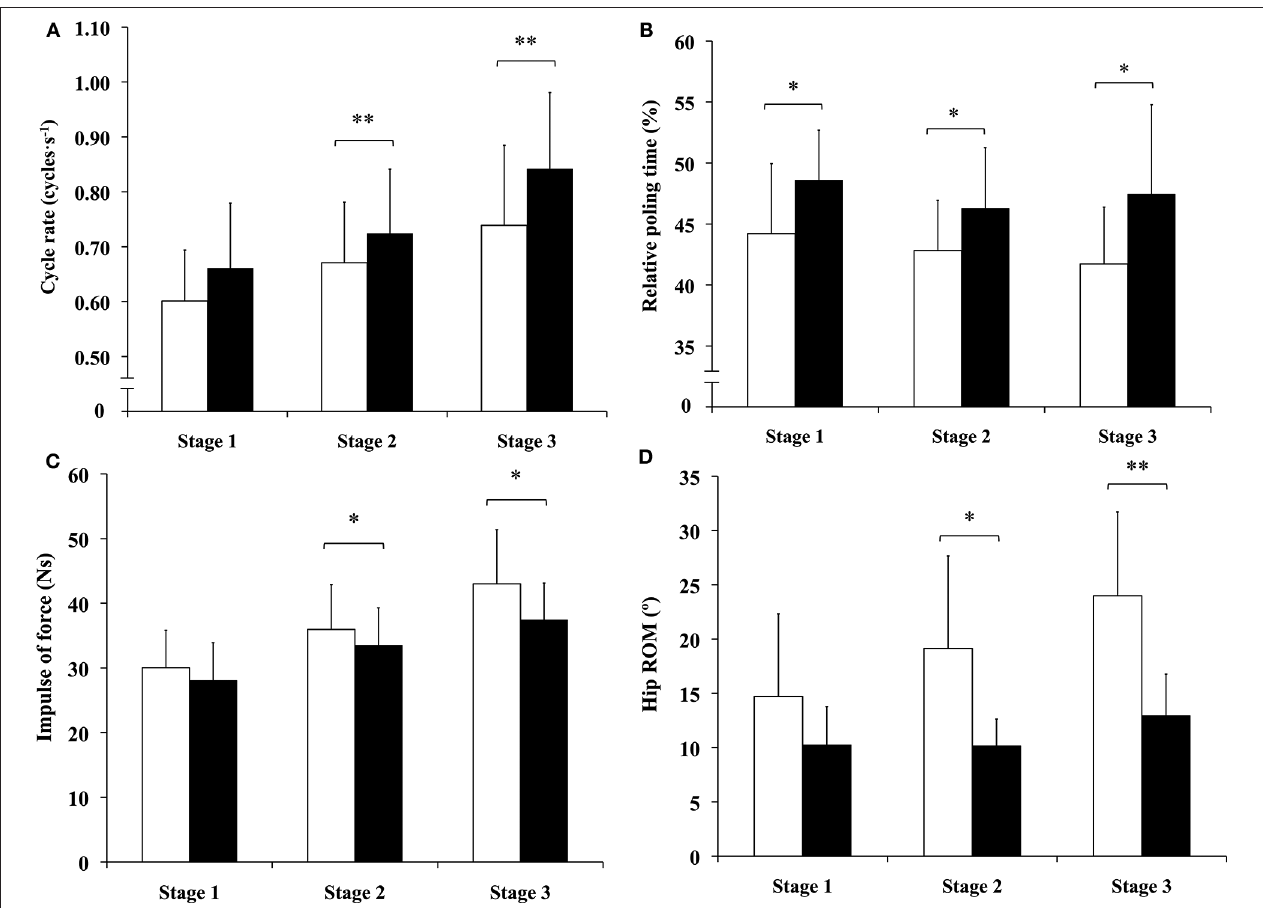
FIGURE 3 | Differences in: (A) cycle rate, (B) relative poling time, (C) impulse of force, and (D) hip range of motion between “kneeing” (white columns) and “knee-high” (black columns) postures during stages one, two and three (13, 22, and 34 percent of maximum sprint power output, respectively). *Statistically significant difference between “kneeing” and “knee-high” postures (* p < 0.05, ** p <